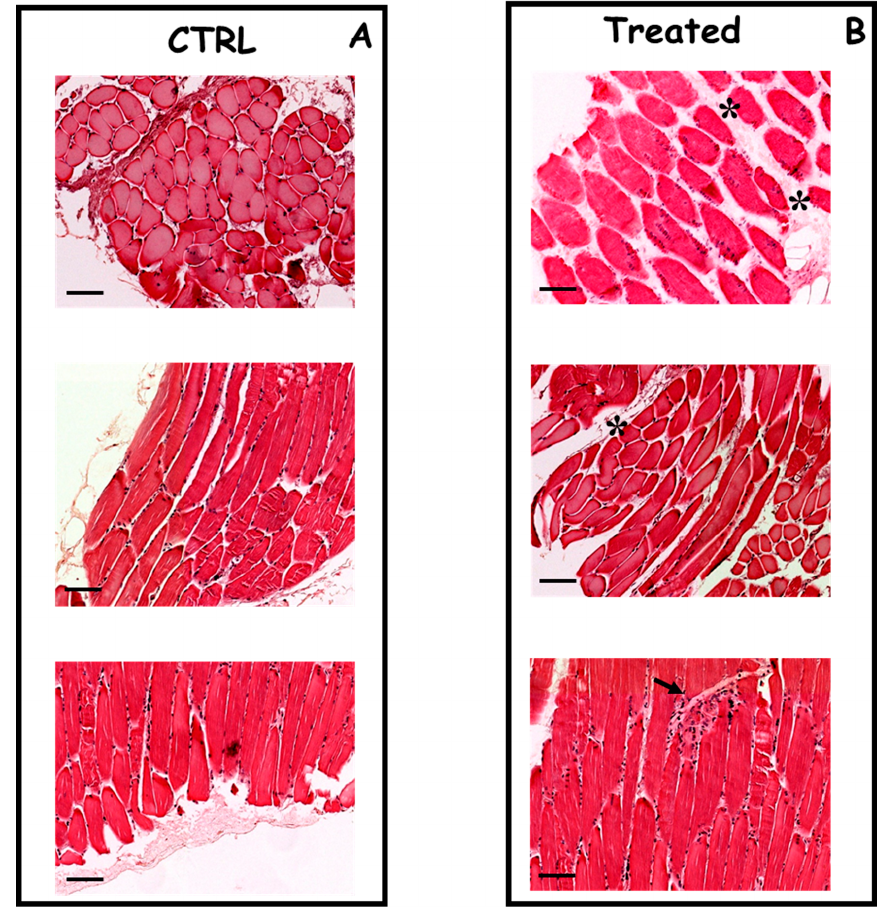
Figure 3. Histopathological analysis of skeletal muscle of mice untreated or treated by needle electrodes. Panel ( A ) cross-sections of skeletal muscle from an untreated mouse, showing no significant histopathological alterations (hematoxylin and eosin, original magnification ×20); Panel ( B ) cross-sections of skeletal muscle from a mouse treated by caliper electrodes showing a focus of mild mononuclear inflammatory infiltrate (arrow) and a slight deviation of the fibers (asterisks). (hematoxylin and eosin, original magnification ×20). Scale bar represents 100 µm for all images. Immunohistochemistry for CD45 was used to analyze the inflammatory response of skeletal tissue undergoing electroporation. Indeed, a significant increased level of CD45 expression was observed in treated skeletal tissue in respect to the control at both 4 and 10 days after electroporation ( p = 0.006 and p = 0.0011 respectively). Interestingly, the level of CD45 expression significantly decreased in the treated animals at 10 days after electroporation in respect to the animal treated at 4 days after electroporation ( p = 0.003) (Figure 4).